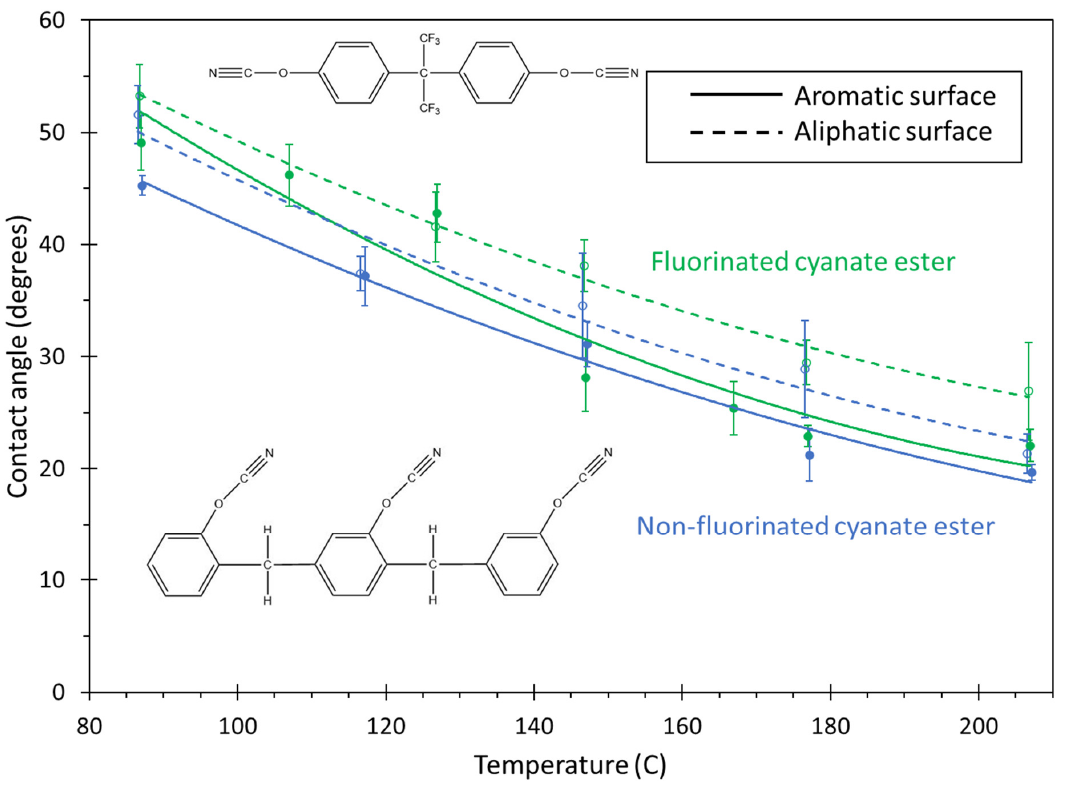
Figure 19. Plot of contact angle vs. temperature for both cyanate ester systems. The lines are curve fits to the data, and the error bars represent the standard error of replicate predictions.